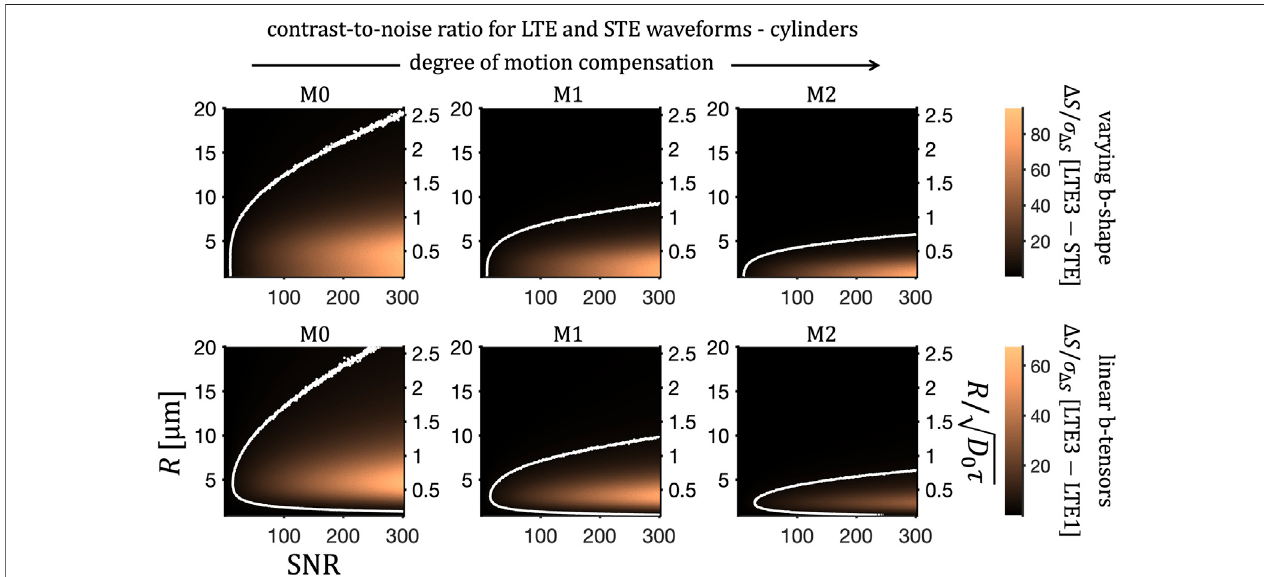
FIGURE11| SizesensitivityforcylindricalporesatvaryingSNR.Contrast-to-noiseratio, Δ S / σ Δ S at b =2 ms/ μ m 2 (asin Figure10 )andfor f R =0.5isshownforM0-, M1-, and M2- (left to right) LTE and STE waveforms. Two common colour scales are used to show contrast-to-noise ratios for rotation-averaged signals from LTE3 and STE (top row) and from LTE1 and LTE3 (bottom row). Contour lines indicate Δ S / σ Δ S = 3.